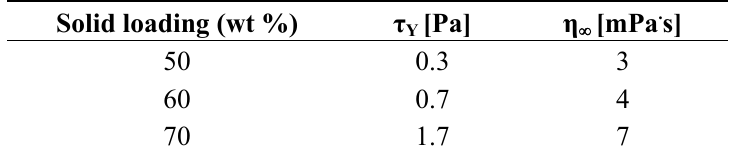
) for suspensions at different solid 